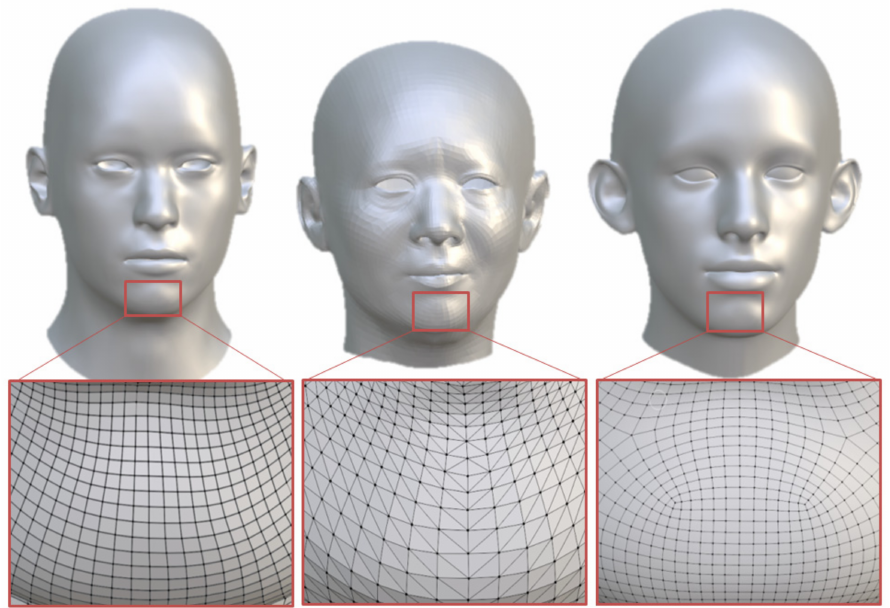
Figure 1. An example of input model and target models with different topologies and